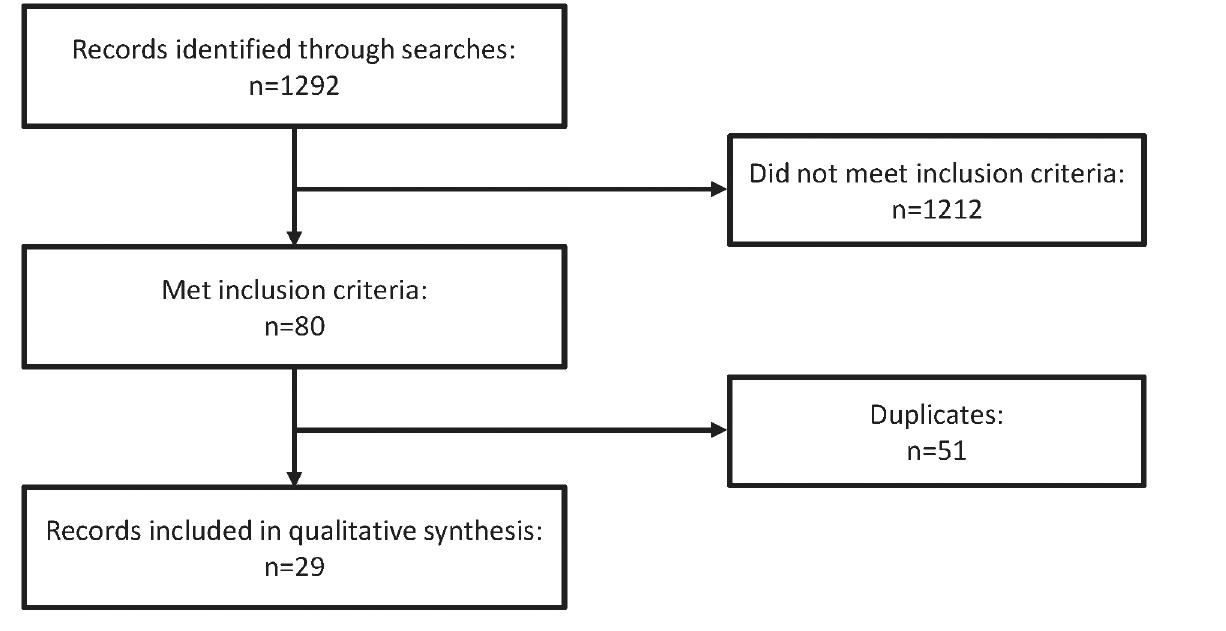
Fig 1. Flow diagram of literature search for systematic